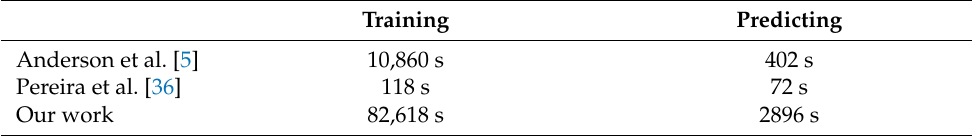
Table 4. Calculation time for each phase in our approach and two